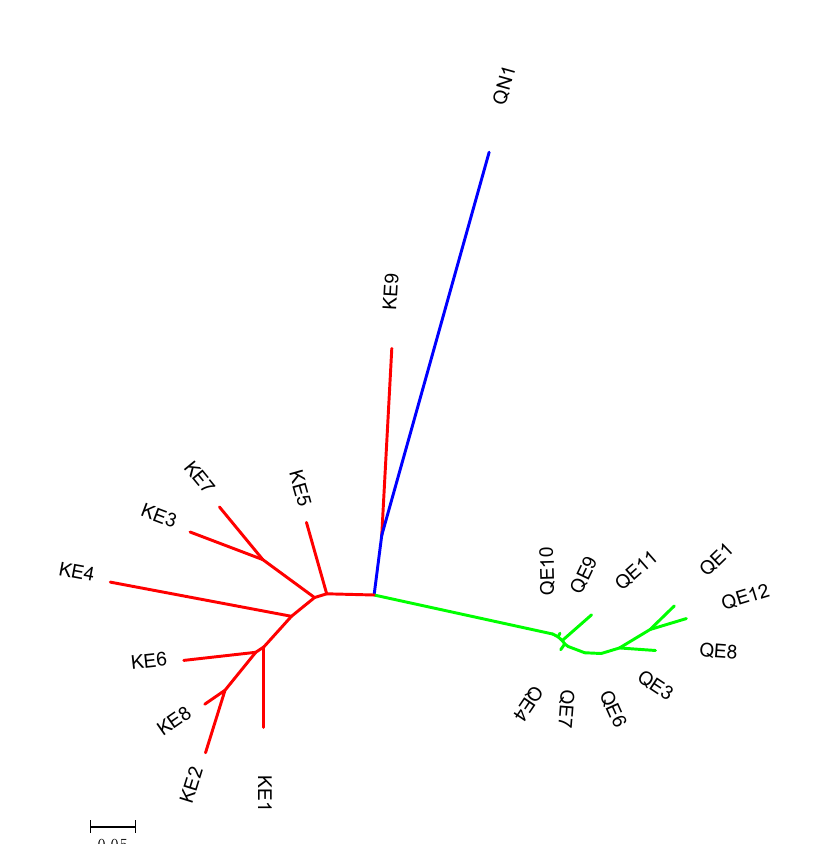
Figure 5. Phylogenetic tree of Phragmites australis populations in native and invasive ranges based on SSR markers using the neighbor-joining method. Colors on branches classified subpopulations, mainly di ff erentiated by geographical origin and ranges.